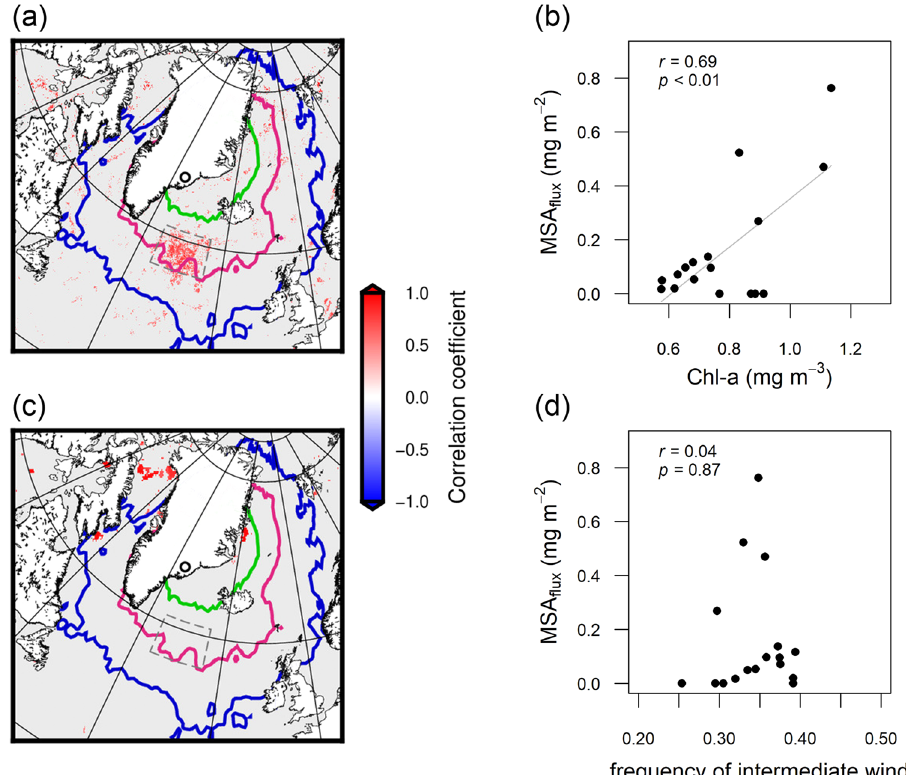
Fig. 4 The relationship between the spring MSA fl ux and each factor. a Correlation coef fi cient between MSA fl ux and Chl-a during spring from 1998 – 2014. b Scatter plot of MSA fl ux and Chl-a during spring. c Correlation coef fi cient between MSA fl ux and the frequency of intermediate wind during spring from 1998 – 2014. d Scatter plot of MSA fl ux and frequency of intermediate wind during spring. Colored regions in a and c denote p < 0.05 with Student ’ s t -test. Green, purple, and blue contours in a and c denote the cumulative density function 40%, 60%, and 80% region, respectively, of air mass probability revealed by the backward trajectory analysis during spring from 1960 – 2014 (Method). Gray dashed boxes in a and c denoted the area of 55°N – 62°N and 22°W – 38°W. The values of the Chl-a in b and the frequency of intermediate wind in d are the spatial means in gray dashed boxes in a and c . Black circles in a and c show the position of the SE-Dome site. Gray line in b is the regression line.